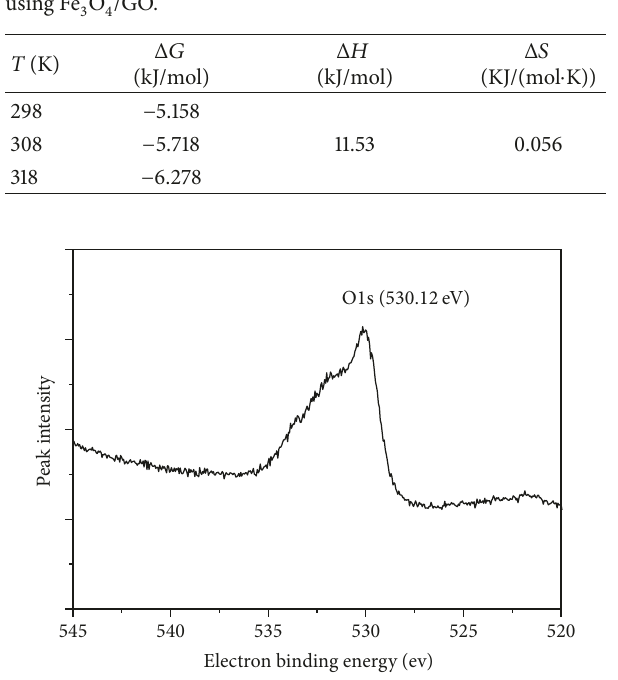
chemical state database, the superficial antimony on the Fe 3 O 4 /GO exists as Sb 2 O 5 , in which the antimony was pen- tavalent. However, the antimony of K(SbO)C 4 H 4 O 6 ⋅ 1/2H 2 O used for preparing stock solutions was as a trivalent species.